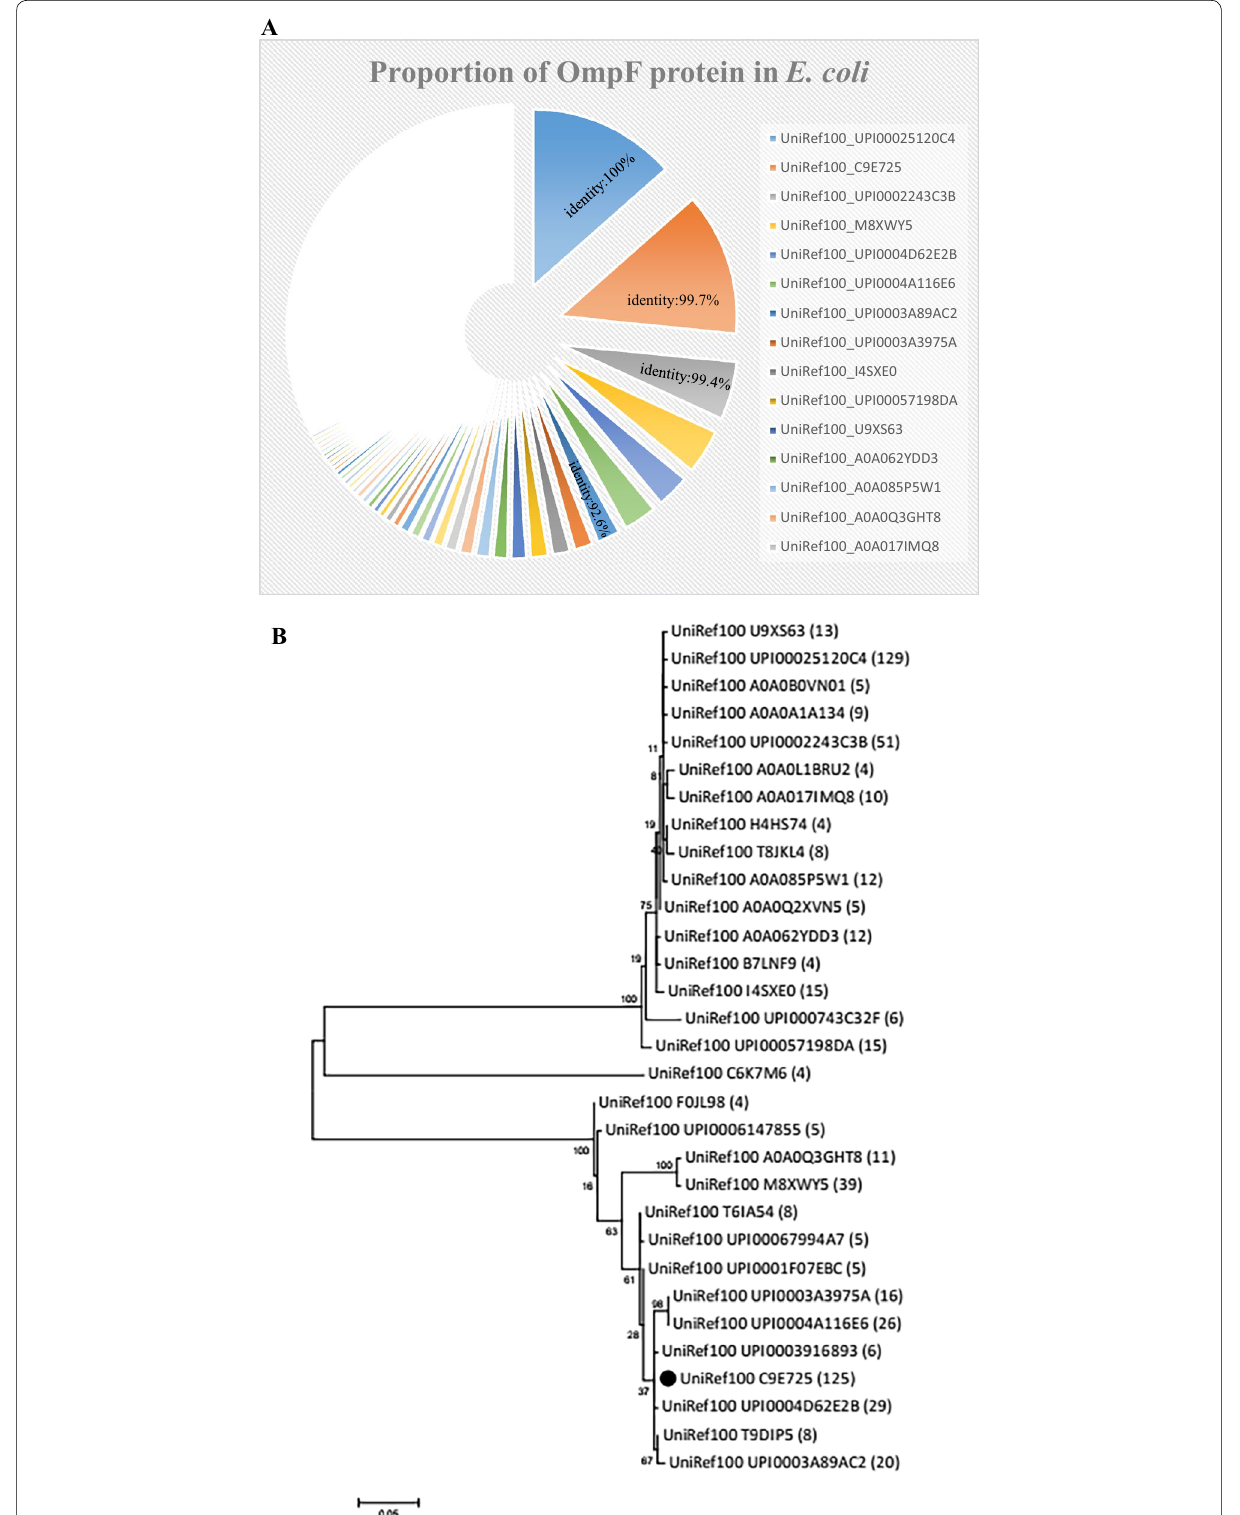
Fig. 1 Homology and phylogenetic analysis of the OmpF protein. A Proportion of the OmpF protein sequences in E. coli (%); B phylogenetic analysis of the OmpF protein in E. coli (omit the clusters less than 4 in size). Black symbol indicates the protein clusters which were identical to that